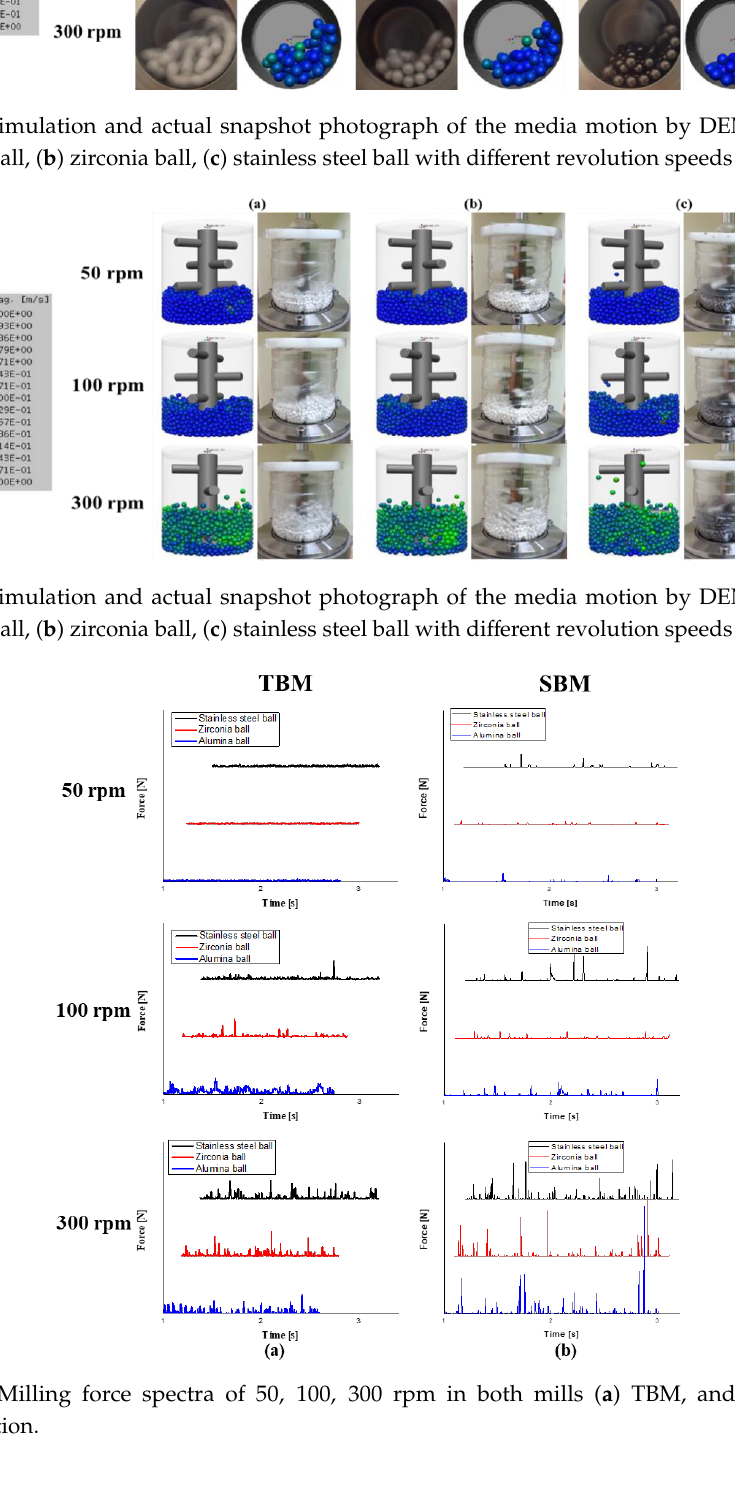
Figure 16. Milling energy spectra of 50, 100, 300 rpm in both mills ( a ) TBM, and ( b ) SBM by DEM simulation.